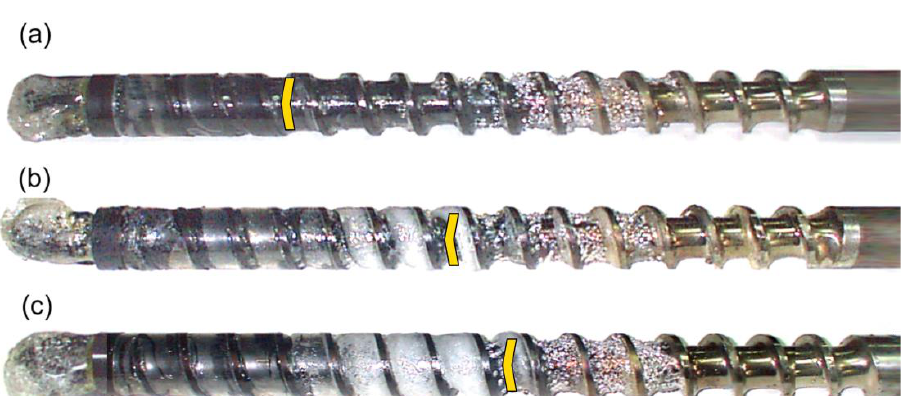
Figure 16. An effect of the back pressure on the polymer flow in the injection molding process at the screw speed N = 100 rpm, and the plasticating stroke h plast = 1 D: ( a ) P back = 0 MPa, ( b ) P back = 2 MPa.